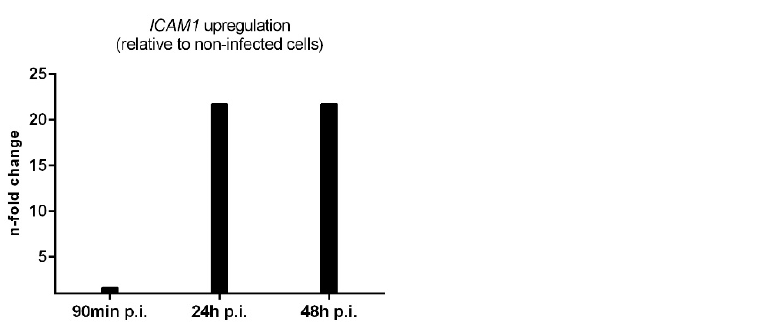
Figure 8. Change of gene expression of ICAM-1 in S. aureus infected endothelial cells relative to noninfected cells.